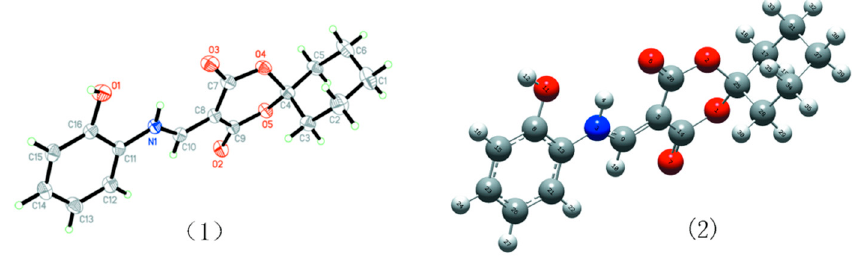
Figure 1. ( 1 ) ORTEP diagram of HMD. ( 2 ) Optimized structure of HMD. Table 2. The selected experimental and B3LYP parameters of HMD.